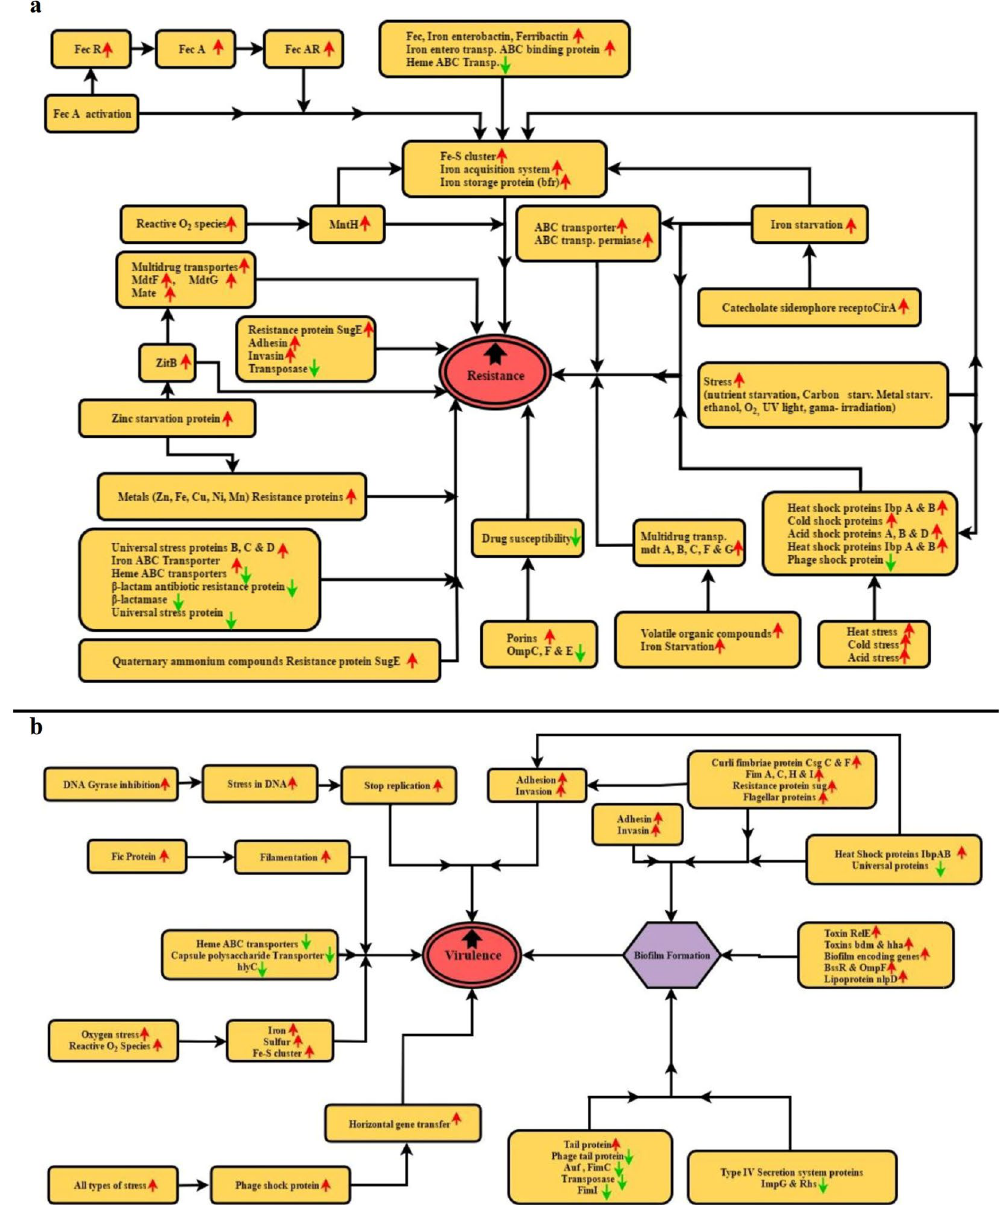
Figure 4. Proposed resistance ( a ) and virulence ( b ) regulating genes and associated factors in isolate E. coli 381. Up-regulated genes and factors are shown with red-colored upward arrows while down-regulated genes and factors are shown with green-colored downward